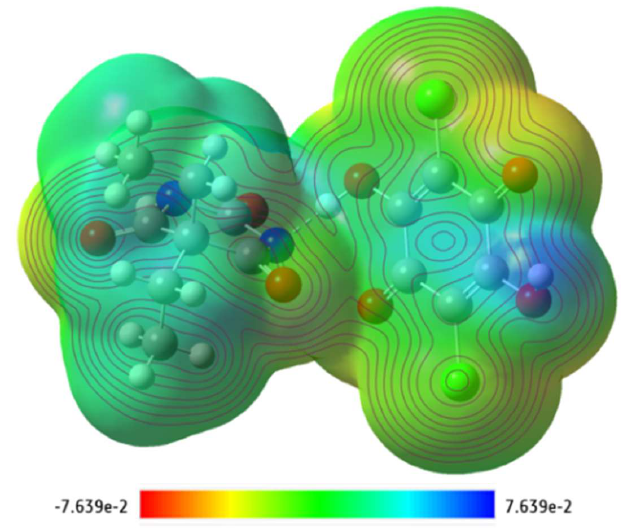
Figure 11. MEP surface map of the (Bar–CLA) complex with respective color scales. The MEP surface generated by DFT describes the nucleophilic or electrophilic prop- erties. Electropositive regions are shown in blue and electronegative zones are shown in red (Figure 11). The red region, referred to as the nucleophilic area and susceptible to electrophilic attack, indicates the highest negative range for (Bar–CLA), which was −7.639